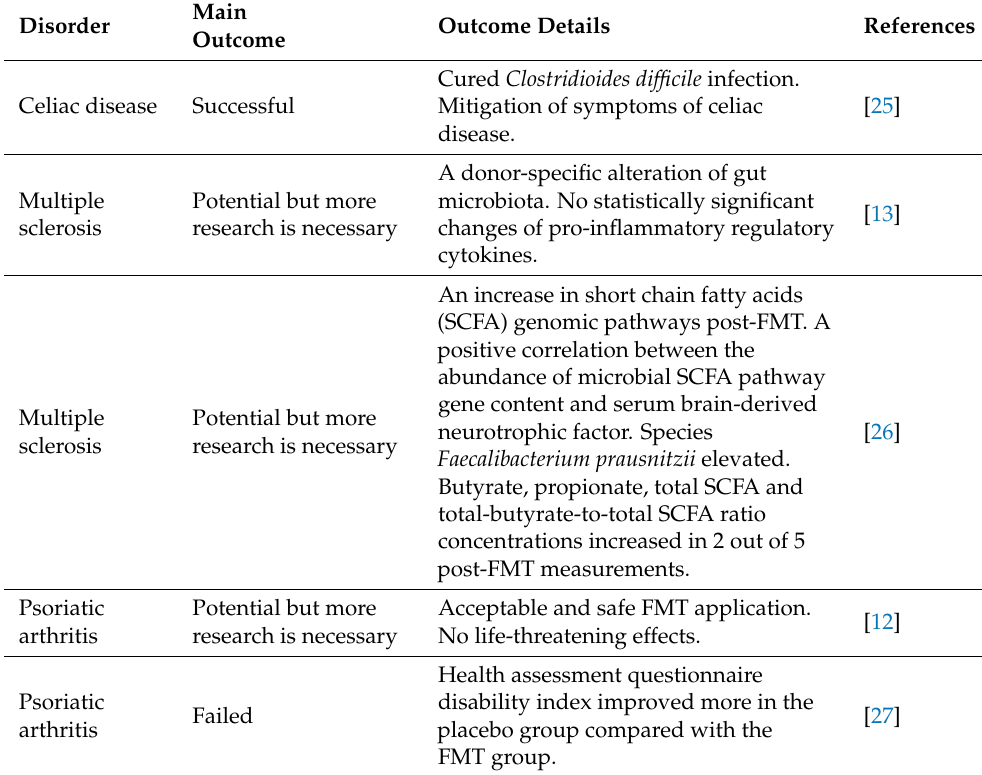
Table 1. Published clinical studies applying FMT in autoimmune diseases. The table summarizes recently published clinical studies in which human donor stool was applied to ameliorate the onset, slowdown the progression or suppress the symptoms of autoimmune diseases, namely celiac disease, multiple sclerosis, psoriatic arthritis, rheumatoid arthritis, Sjogren’s syndrome and type I diabetes. The table summarizes the main outcomes of FMT application and highlights interesting outcome